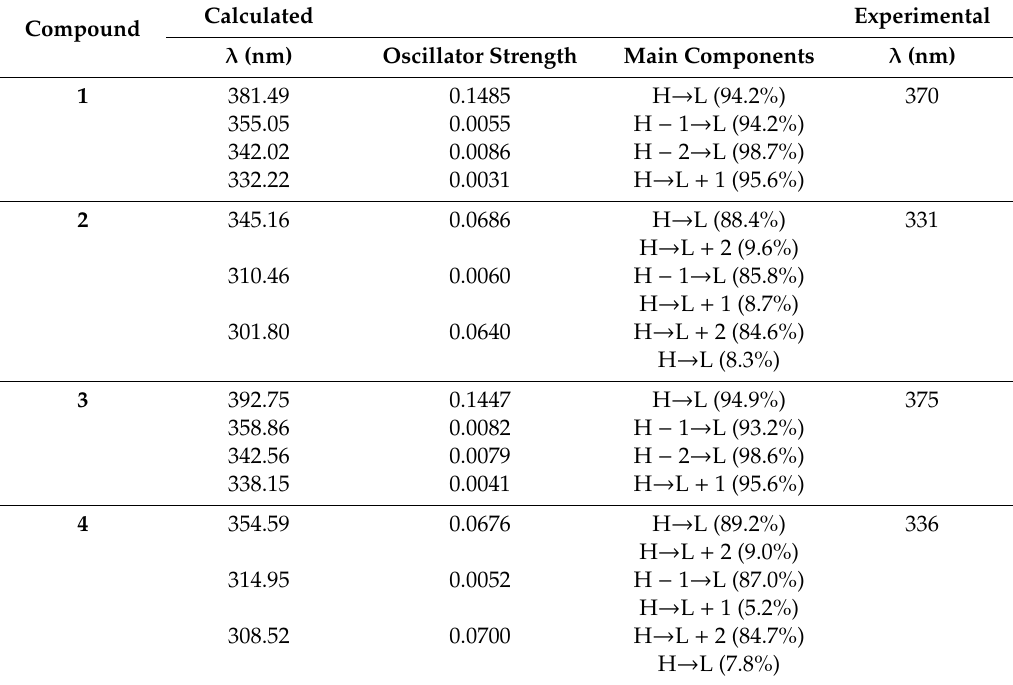
Figure 7. Ultraviolet-visible (UV-Vis) spectra of free dithiol ligands and their arsenic(III) compounds. Table 3. The highest wavelength absorption data from experiments and calculations (TD-DFT) for the studied arsenic(III)